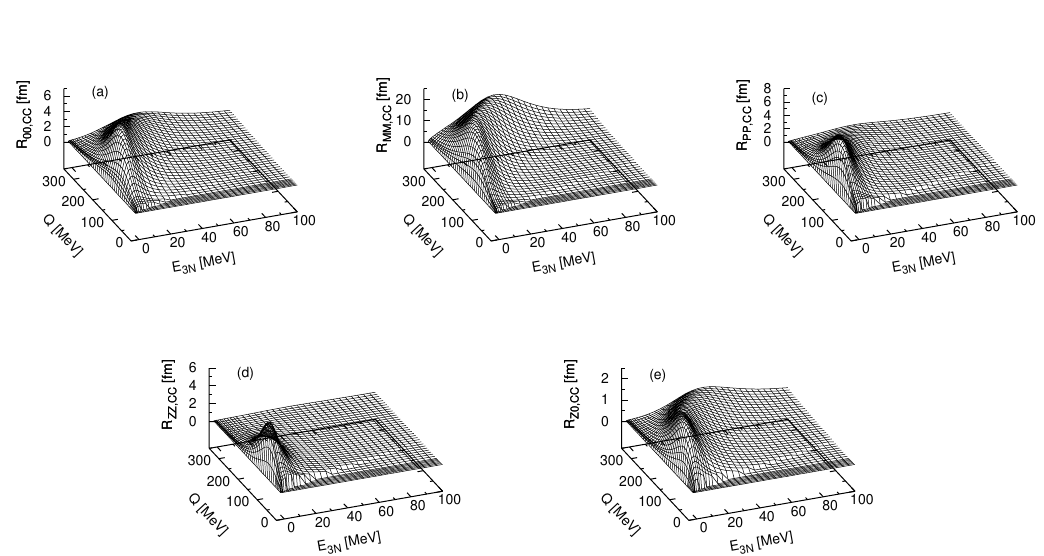
Figure 1: The response functions for the charged current reactions on 3 He as a func- tion of the internal hadronic energy in for the 3N system E momentum Q . The figure has been taken from Ref. [ 6 ]